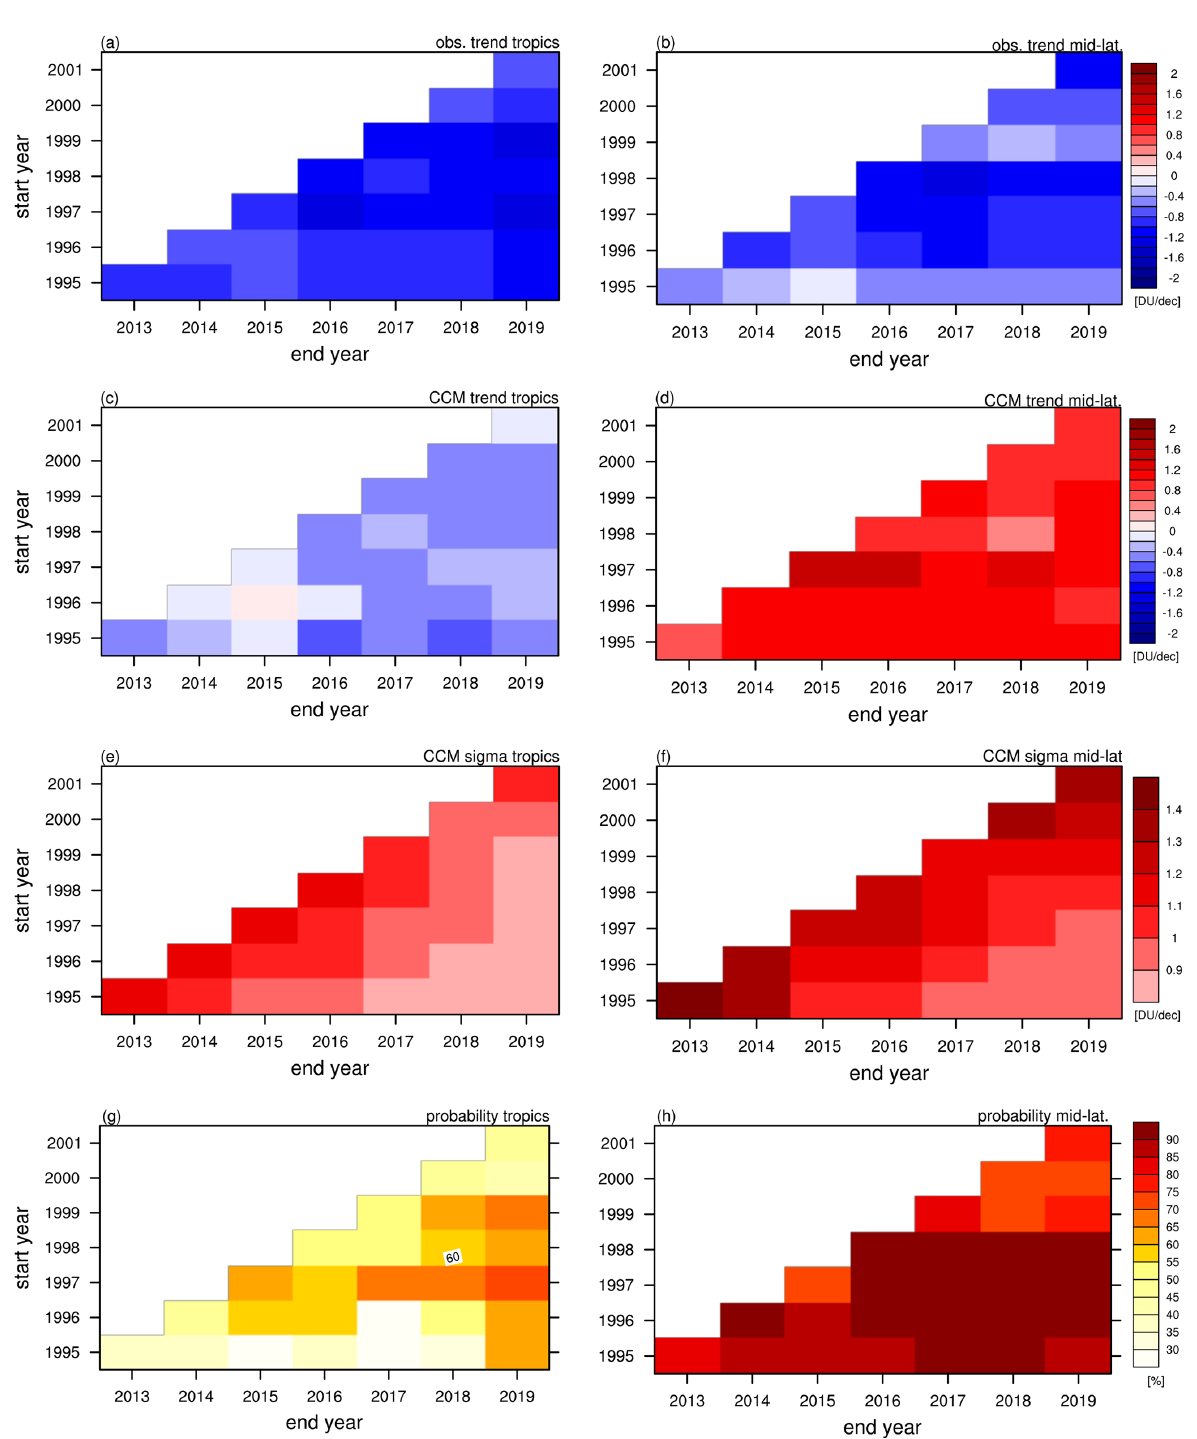
Figure 4. Tropical (a, c, e, g) and mid-latitude (b, d, f, h) LS ozone trends (in DU per decade) as a function of different periods for the observational trend of BASIC SG (a, b) , the most likely trend of the modelled REF-C2 probability distribution (c, d) , and the 1 σ standard deviation (in DU per decade) of the mean obtained from the probability distribution (e, f) . The panels (g) and (h) show the “probability of disagreement” (in per cent) between observed trends and the REF-C2 trend probability distribution. In all panels the x coordinate denotes the different end years (2013–2019) and the y coordinate the different start years